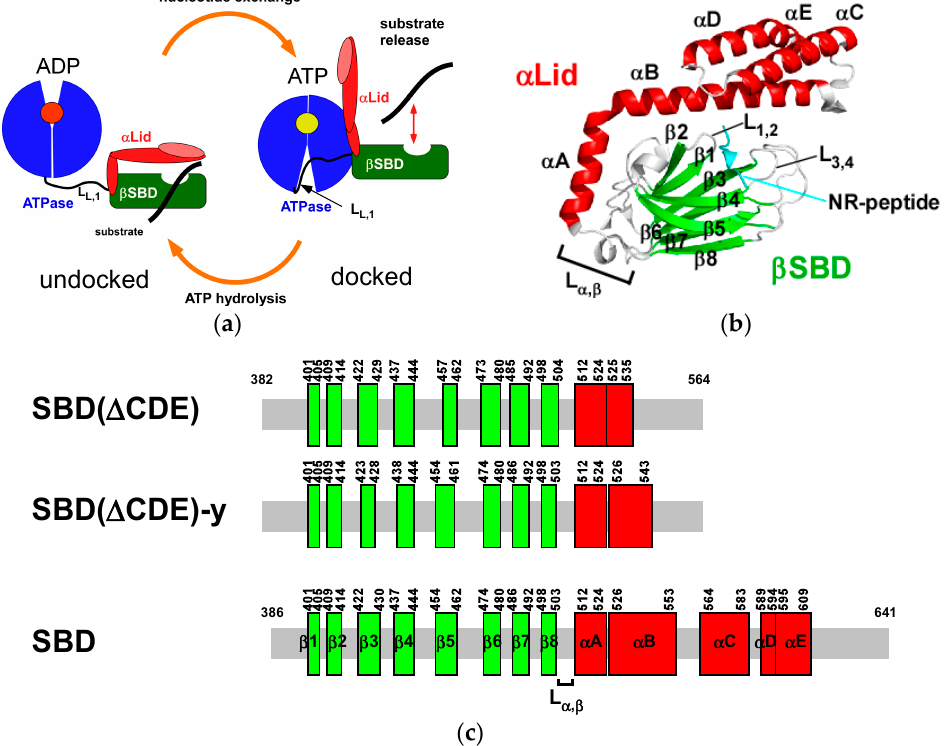
Figure 1. Hsp70 chaperone cycle and the domain architecture of the SBD. ( a ) Schematic drawing of the Hsp70 chaperone cycle; ( b ) The crystal structure of the SBD in human Hsp70 (HSPA1A) complexed with the NR-peptide harboring the sequence NRLLLTG (PDB ID: 4PO2) [15]; ( c ) The architecture of the SBD constructs used in this work. Secondary structures depicted for SBD( ∆ CDE) and SBD( ∆ CDE)-y were determined by NMR. SBD depicts the full-length sequence of the substrate-binding domain with the secondary structure taken from the crystal structure of the substrate-bound SBD in Hsp70 (PDB ID: 4PO2).